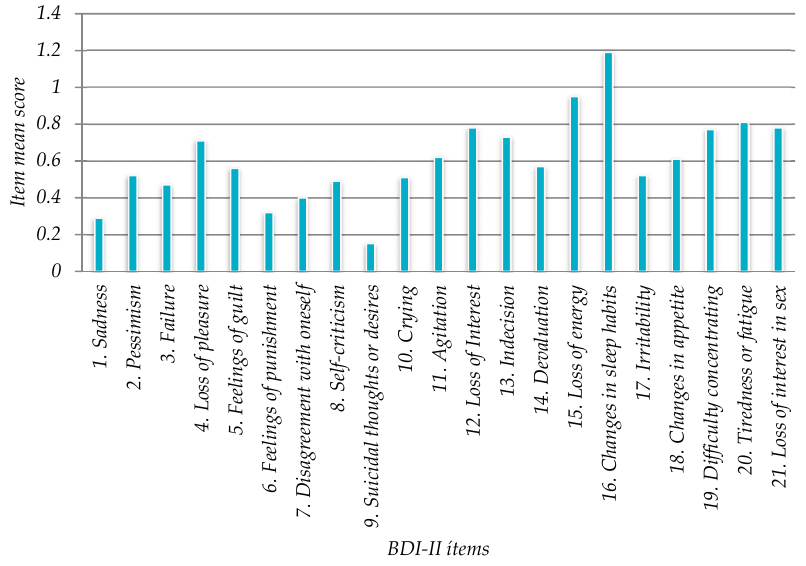
Figure 6. Mean values of 21 BDI-II items.